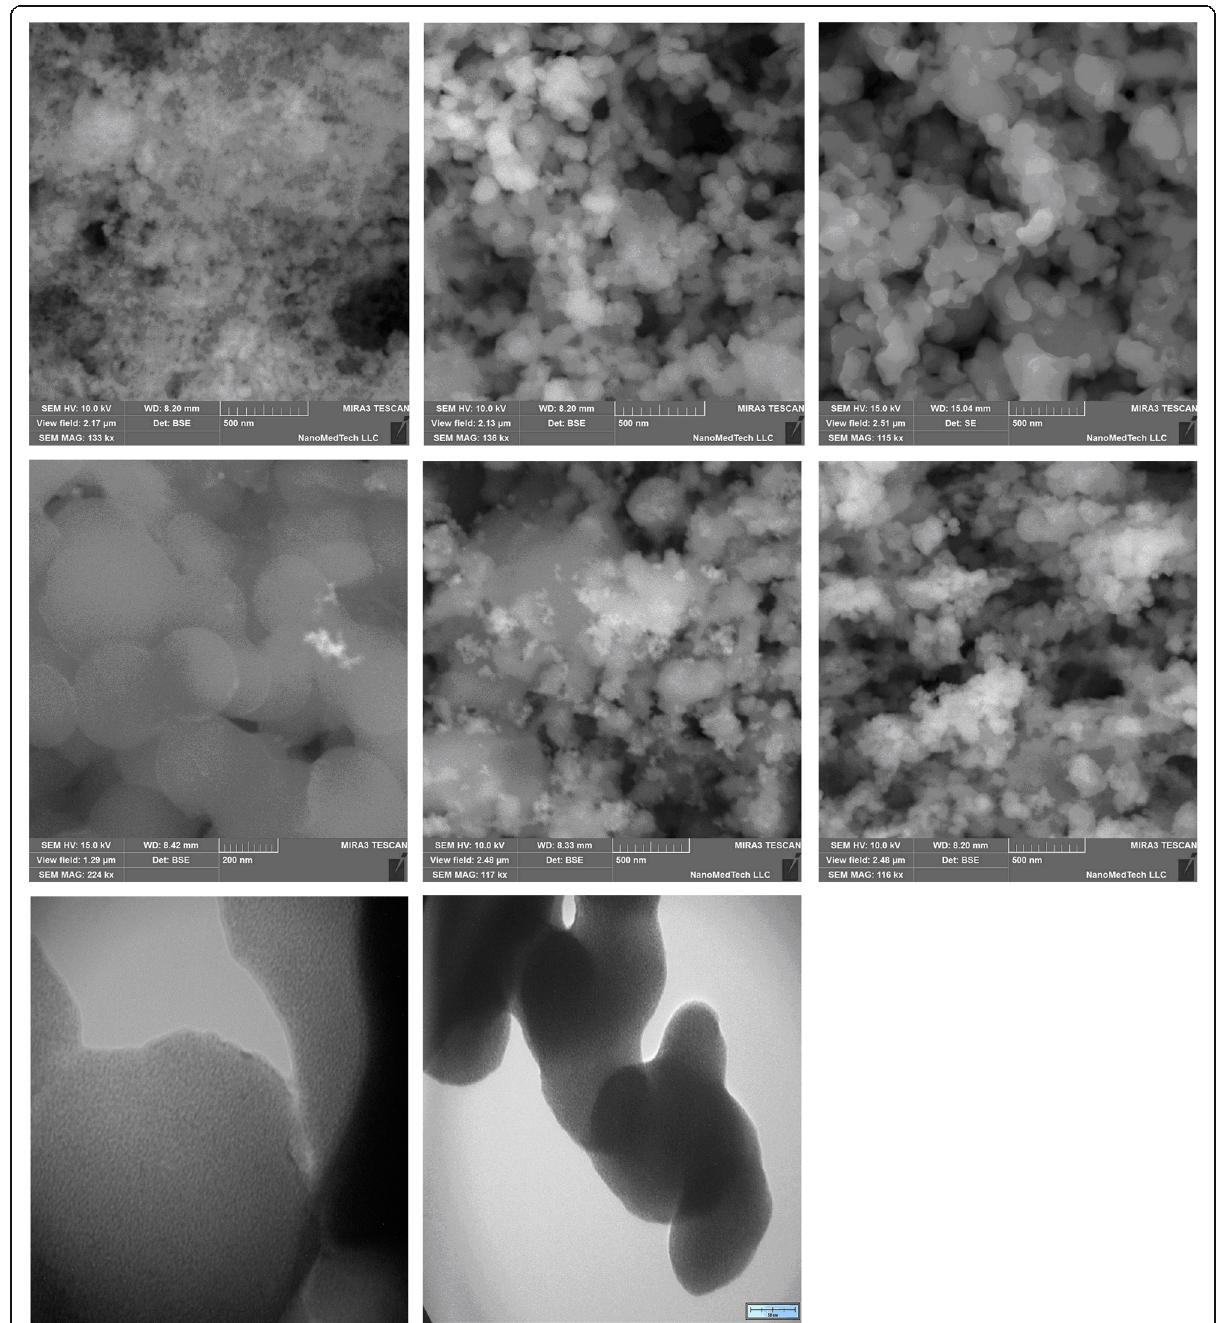
Fig. 4 SEM image of powder 1 — Nd(mphpd) 3 , 2 — [Nd(mphpd) 3 ] n , 3 — [Nd(mphpd) 3 ] n ⋅ [VK] m , 4 — [Nd(mphpd) 3 ] n ⋅ [styrene] m , 5 — Nd(alacac) 3 ⋅ 2H 2 O, and 6 —